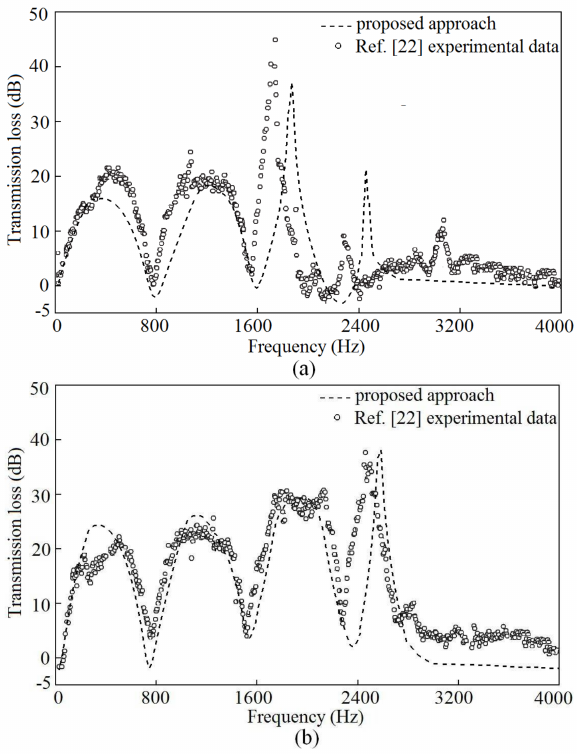
Figure 4. Comparison of the predicted and measured transmission loss ( TL ) for the straight-through perforated tube silencer (Mach number M = 0.1, Temperature T = 288 K): ( a ) Pattern 1; ( b ) Pattern